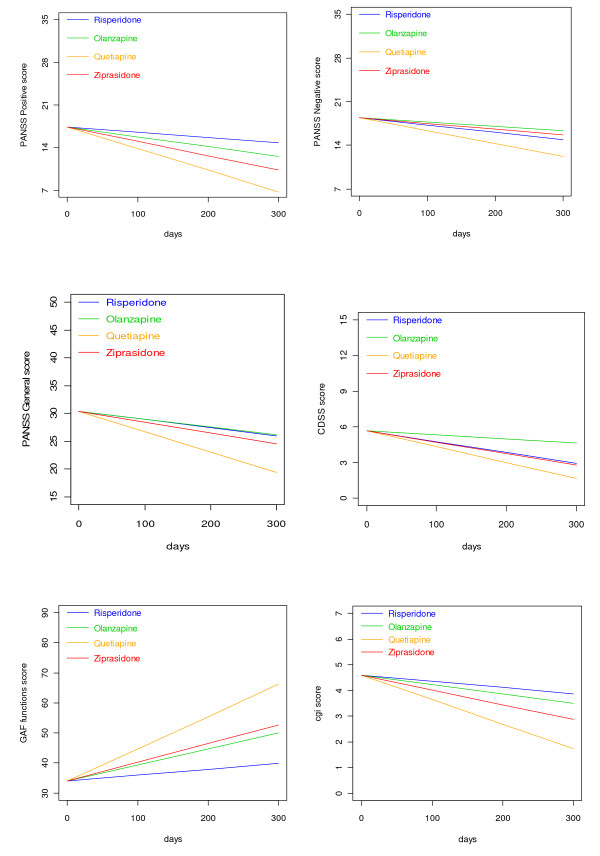
Change of PANSS subscores, CDSS, GAF-F, and CGI-S scores. The curves are generated based on drug-specific linear mixed effects slopes as displayed in Additional file 2 for risperidone, olanzapine, quetiapine, and ziprasidone, respectively. PANSS = the Positive and Negative Syndrome Scale; CDSS = the Calgary Depression Scale for Schizophrenia; GAF-F = the Global Assessment of Functioning scale - Split Version, Functions scale; CGI-S = the Clinical Global Impression - Severity of Illness Scale. The curves are confined to the first 300 days because the major bulk of data is obtained before 300 days.